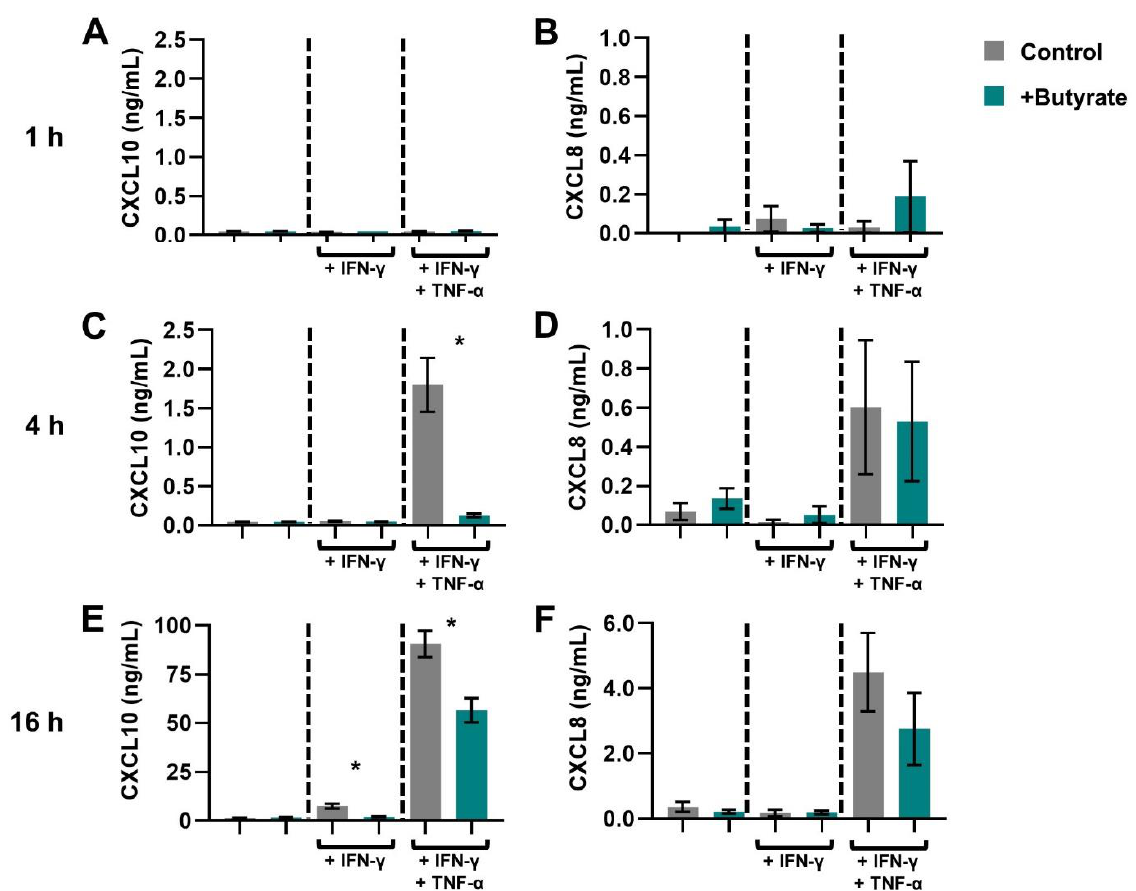
Figure 2. Chemokine release in time by intestinal epithelial cells activated with IFN- γ or IFN- γ +TNF- α and treated with 2 mM butyrate (green bars). CXCL10 ( A , C , E ) and CXCL8 ( B , D , F ) release was measured after 1, 4 and 16 h incubation. Data are represented as mean ± SEM ( n = 4). Significant differences are shown as * p < 0.05 tested with a paired t -test between control and butyrate treated cells.